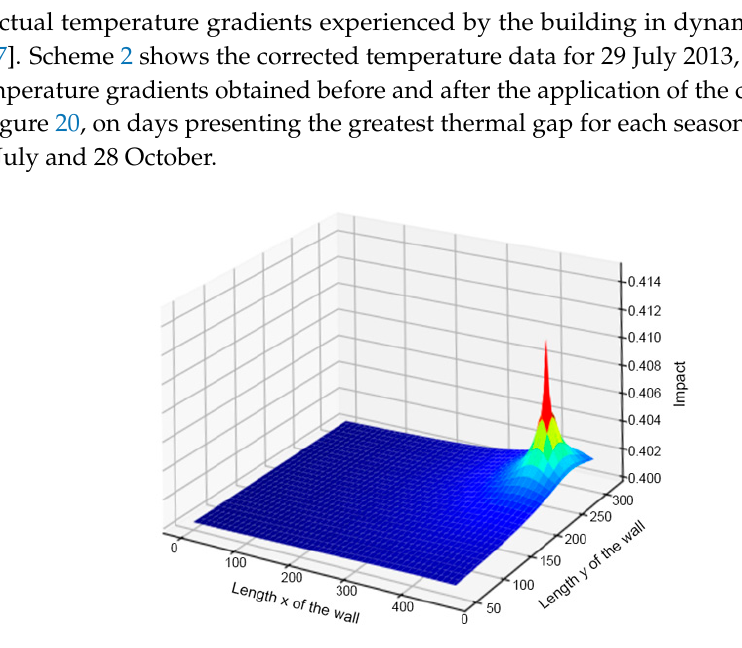
Figure 19. Flow diagram showing the impact of the change of materials used in an area of each of the points of the wall.